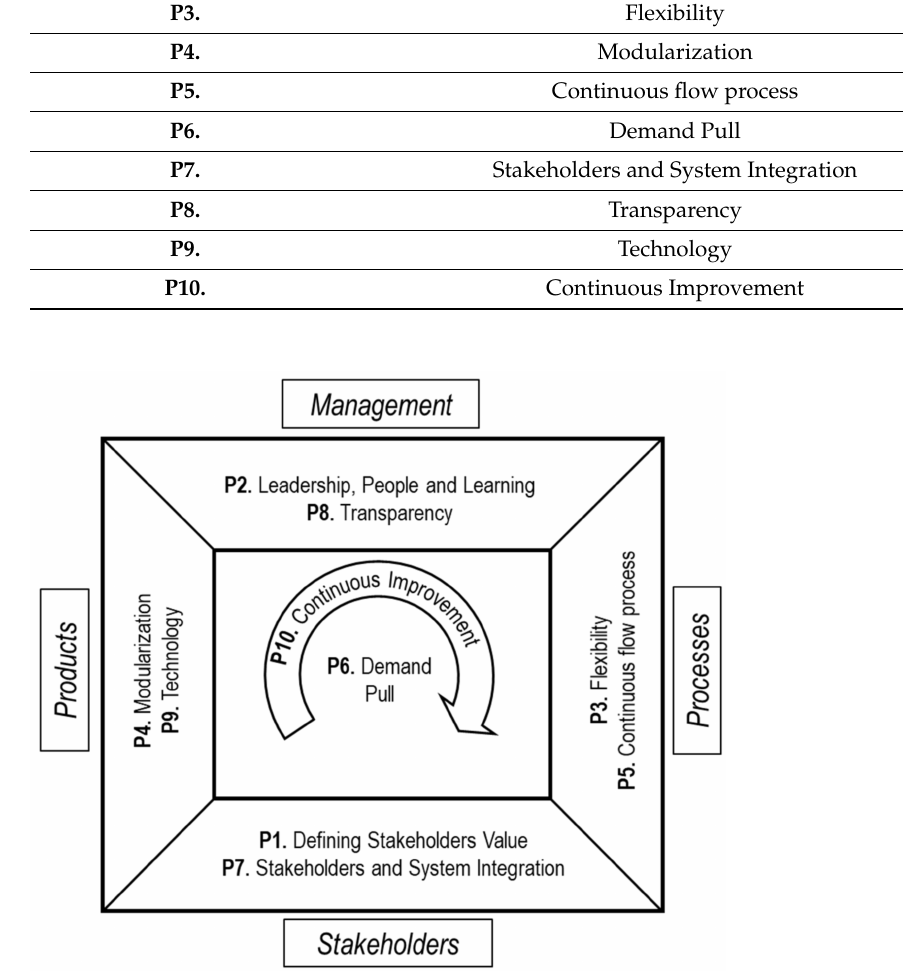
Figure 3. Map of ten ETO lean